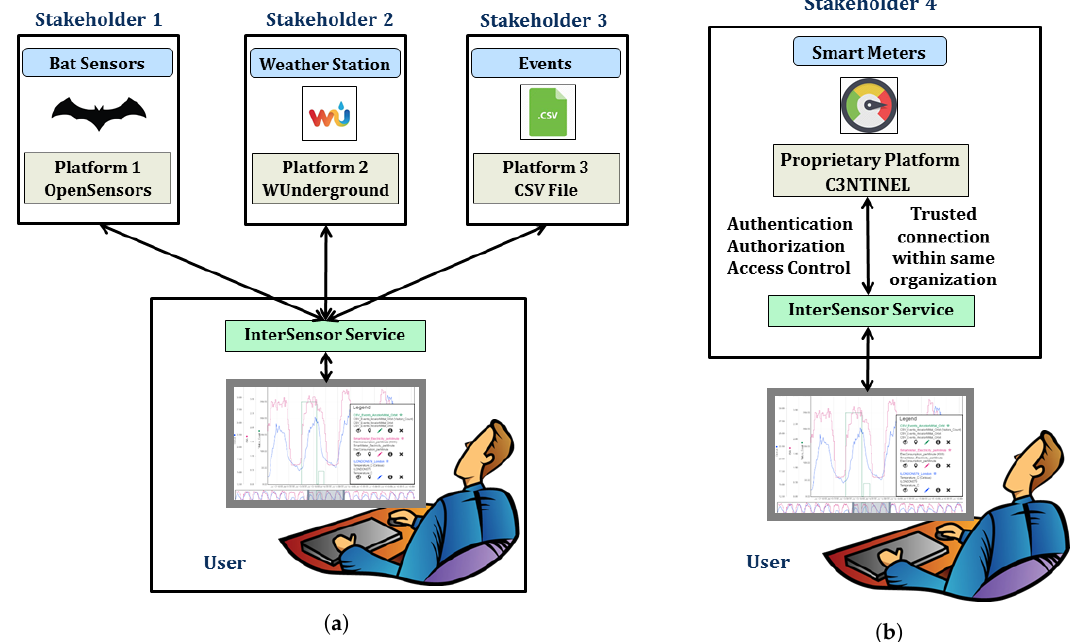
Figure 7. An InterSensor Service can be deployed ( a ) by a user connecting to different data sources, as well as ( b ) by a stakeholder by setting up a trusted connection within same